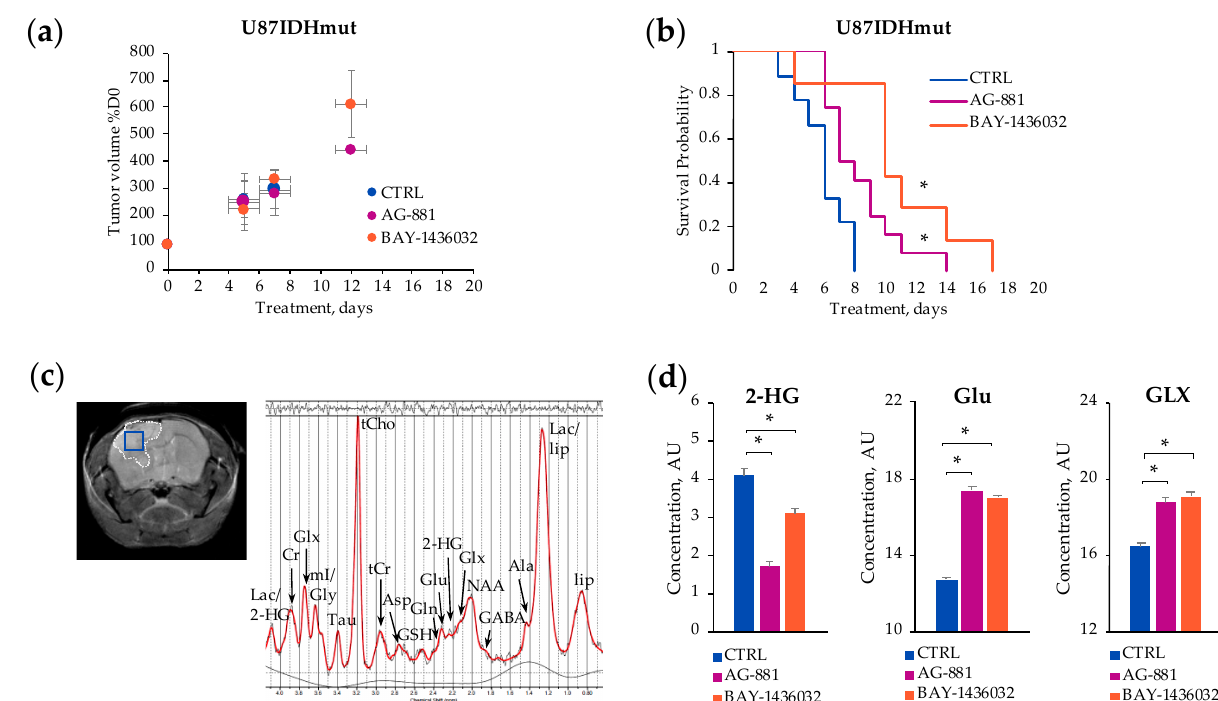
Figure 2. Temporal evolution of average U87IDHmut tumor volume as a percentage of D0 ( a ). Kaplan–Meier survival plot of U87IDHmut-bearing mice (* p -value ≤ 0.05) ( b ). A representative axial T 2 -weighted image of control U87IDHmut-bearing mouse and corresponding in vivo 1 H-MRS spectrum acquired from the voxel marked in blue on the image ( c ). Quantification of 2-HG, Glu and GLX concentrations acquired from the voxel placed in control, AG-881- and BAY-1436032-treated tumors at D5 ± 1 (* p -value < 0.003) ( d ).